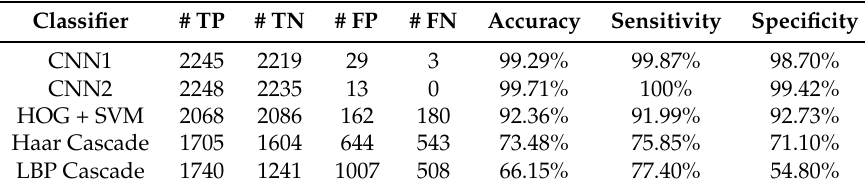
Table 3. Classifier evaluation